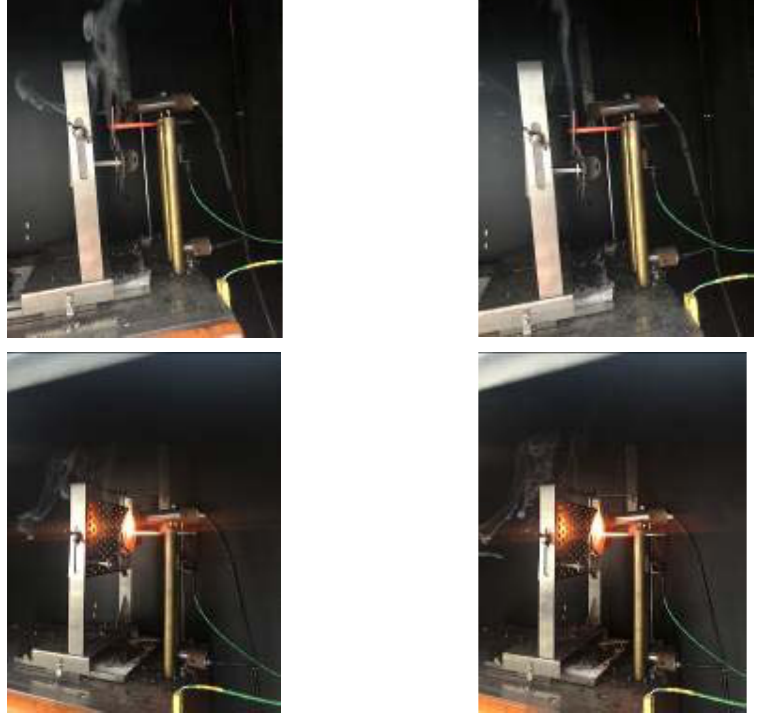
Figure 10. Non-combustion and extinguishing after combustion in the hot wire test.